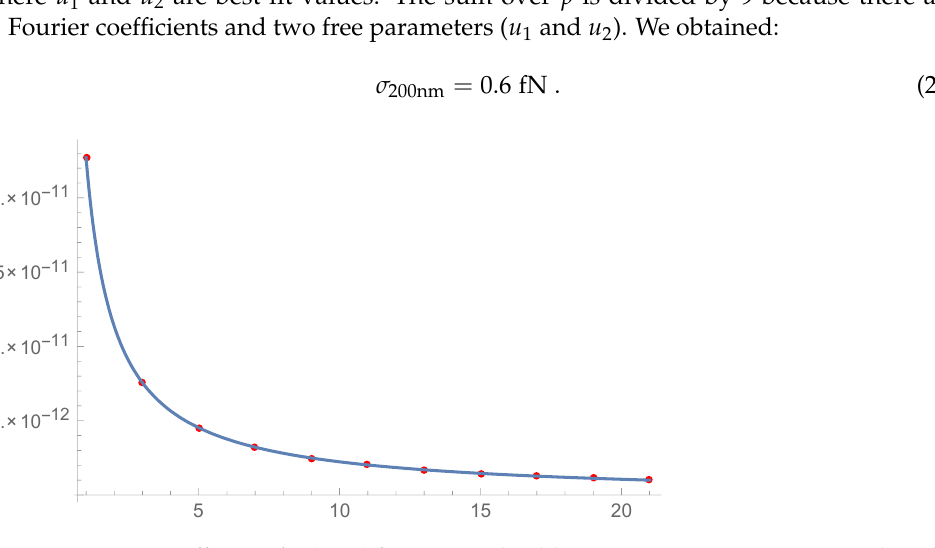
Figure 5. Fourier coefficients b m (in N) for sines with odd m = 1,3,5, . . . at z = 200 nm. The solid line is a best fit of the data by the curve b m = u 1 / m + u 2 m